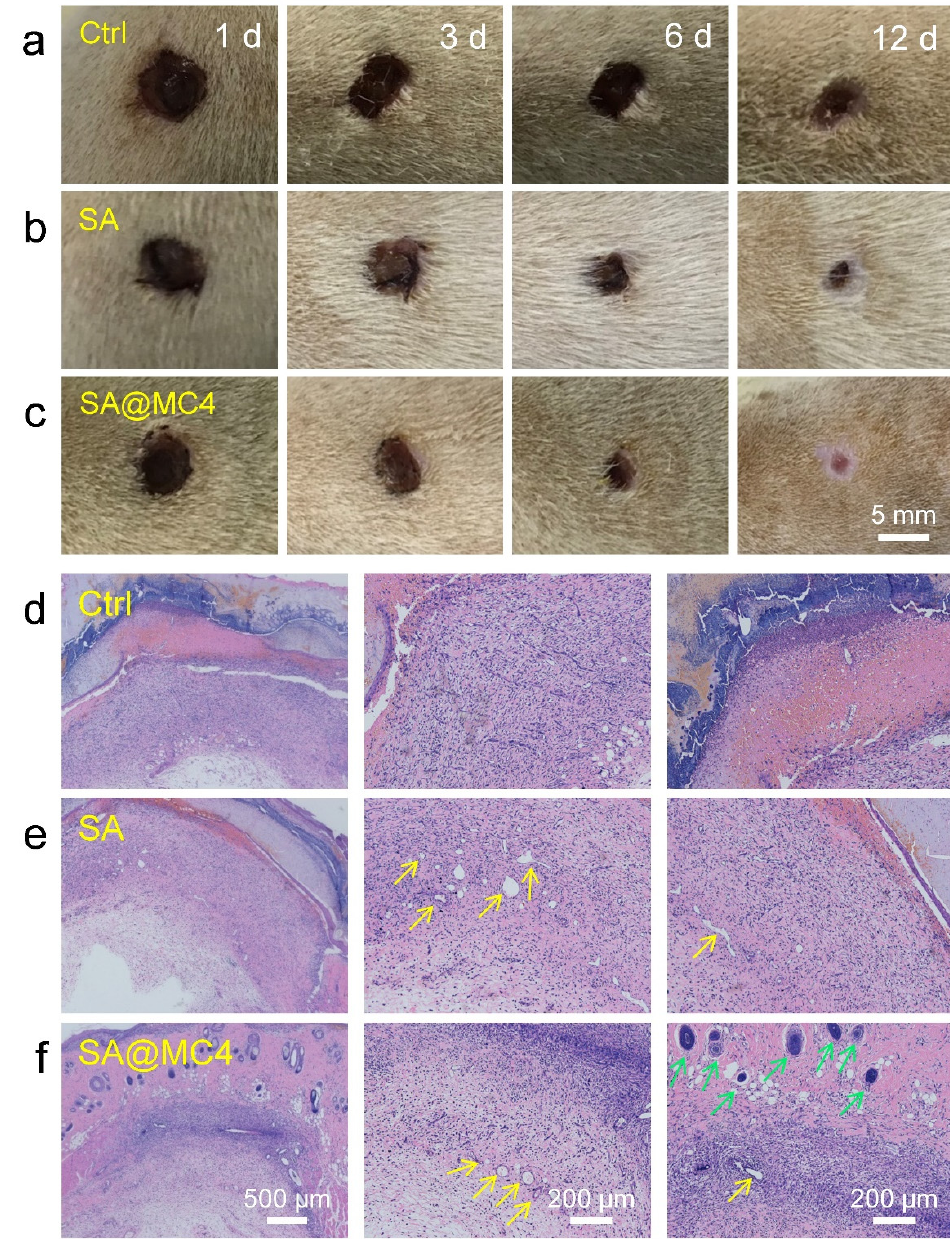
Figure 6. Wound healing ability assessment. ( a – c ) Photographs of wounds on the 1st, 3rd, 6th, and 12th day after treatment with PBS, SA hydrogel, and SA@MC4 hydrogels; ( d – f ) histomorphological evaluation of wound regeneration after treatment with PBS, SA hydrogel and SA@MC4 hydrogels on the 6th day (blood vessels: yellow arrows; hair follicles: green arrows).